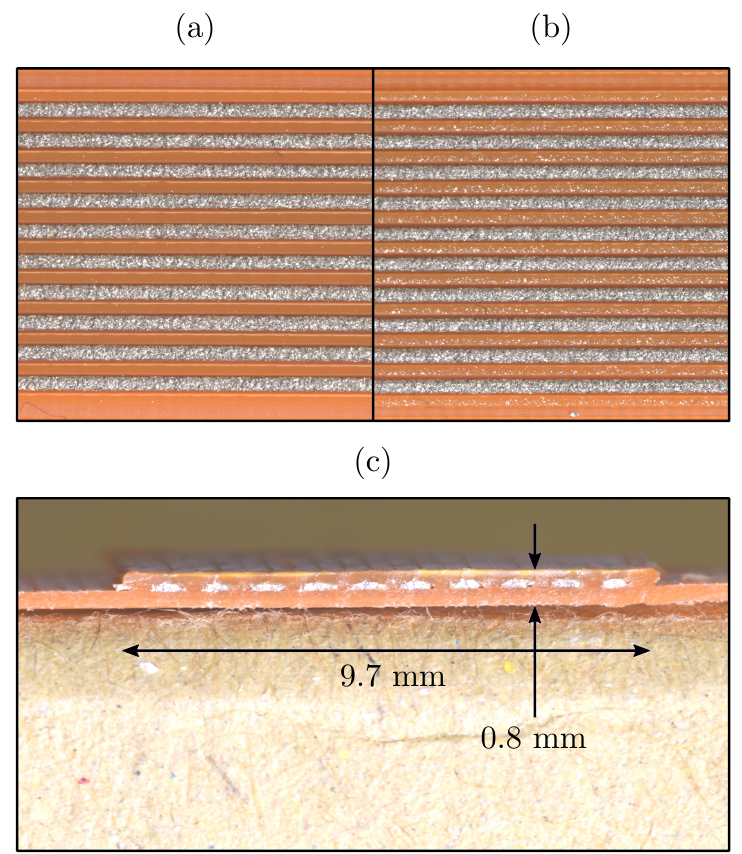
Figure 8. Embedded conductive traces: ( a ) corresponding to Figure 7b, ( b ) corresponding to Figure 7c; ( c ) section of a sample with PLA